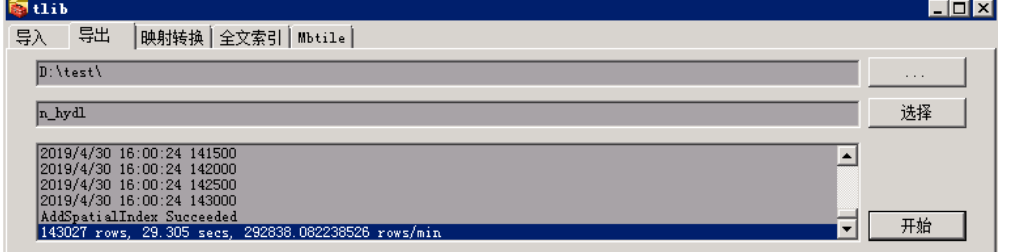
Table 6. Use clustering for SQL spatial analysis.